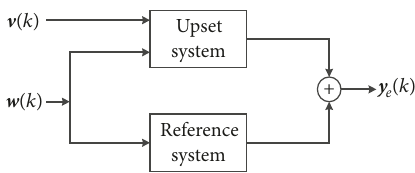
Figure 2: Switched error system structure for flight performance.